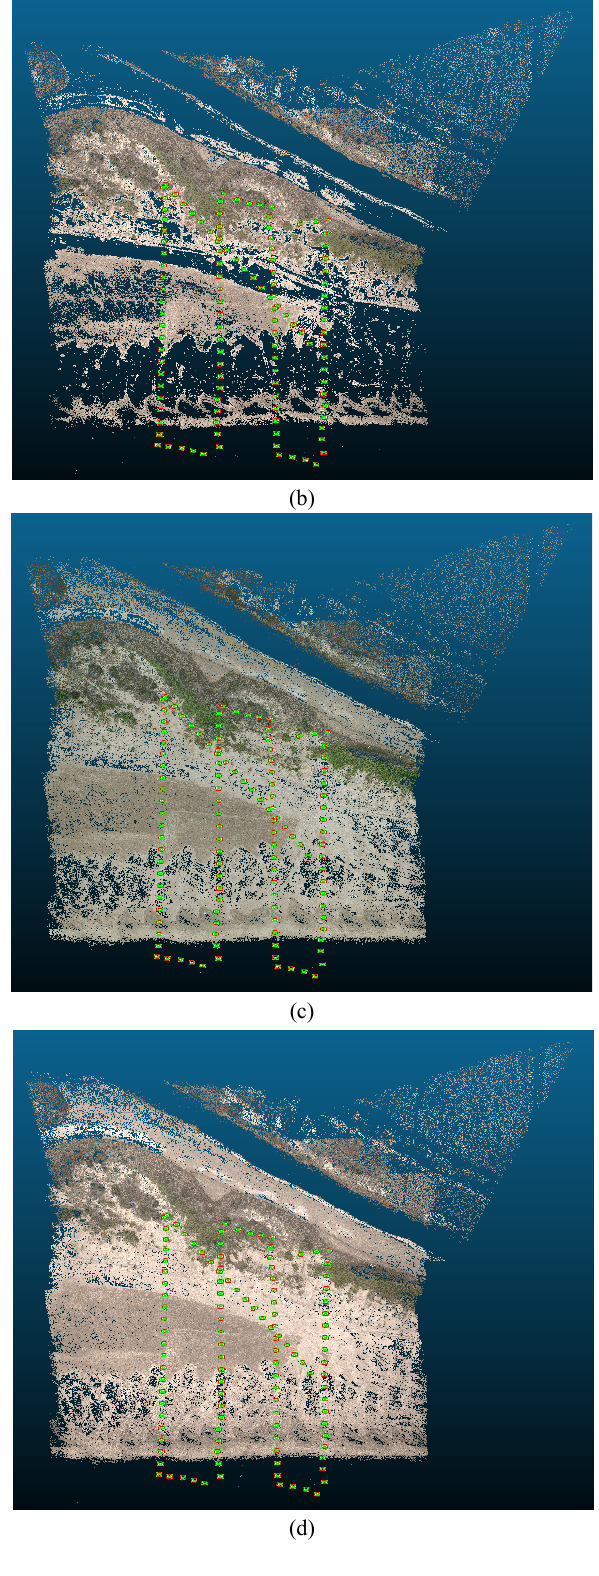
Figure 4. Point clouds obtained with jpg and raw images with and without contrast enhancement: 4a – JPG images without enhancement; 4b – RAW images without enhancement; 4c – JPG images with enhancement; 4d – RAW images with